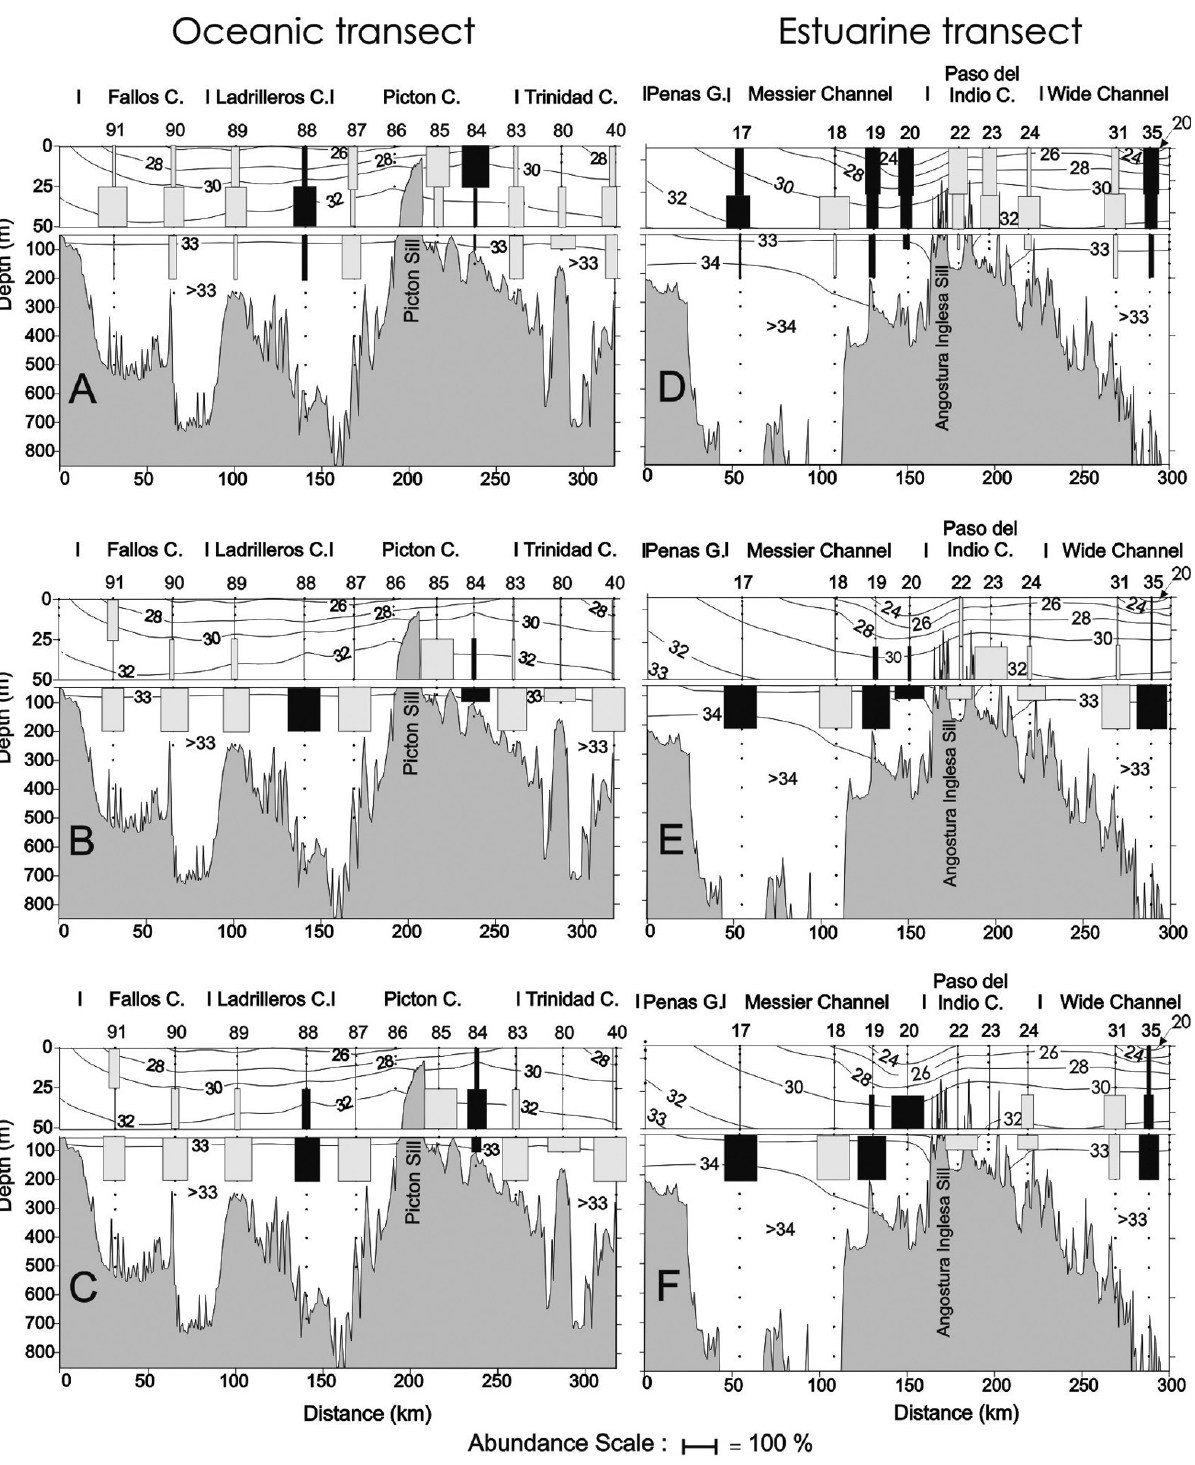
Fig. 4. – Vertical distribution in spring 2008, of polygastric stages in terms of relative abundances at each station (boxes) and salinity (iso- lines), in the longitudinal oceanic transect (OT) and estuarine transect (ET). A-B, Muggiaea atlantica ; C-D, Lensia conoidea ; E-F, Dimophyes arctica . Grey boxes, diurnal tows; black boxes, nocturnal